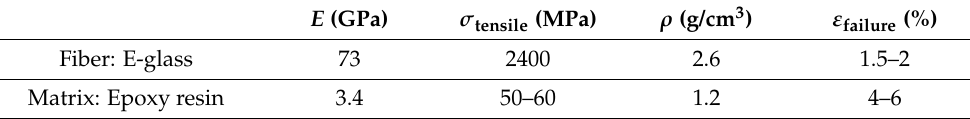
Table 1. Geometric dimensions of the composite pipe and the impactor. Table 2. Mechanical properties of fiber and matrix.